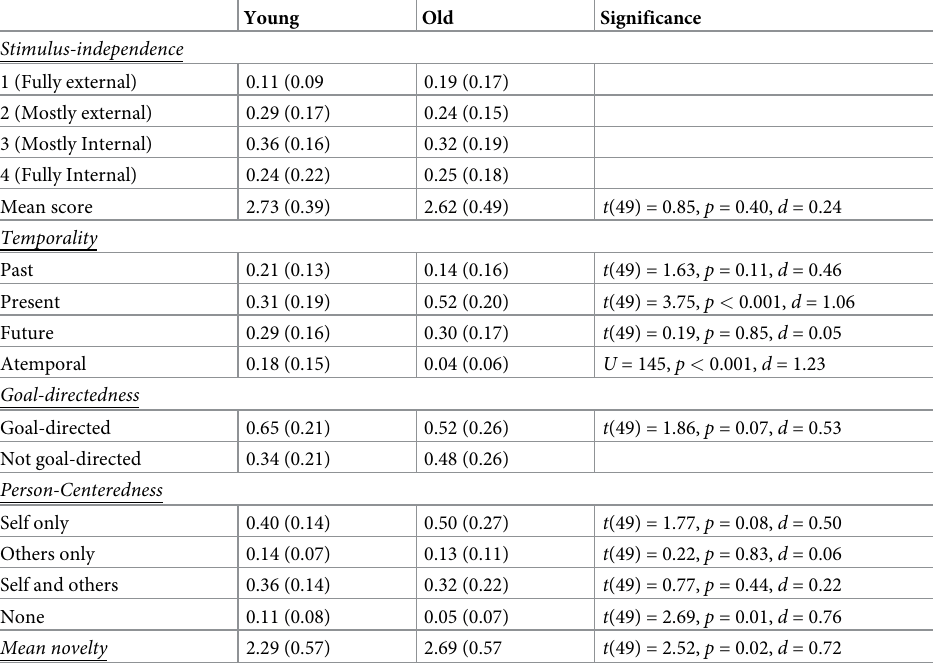
Table 1. Behavioural results, mean (SD). Young